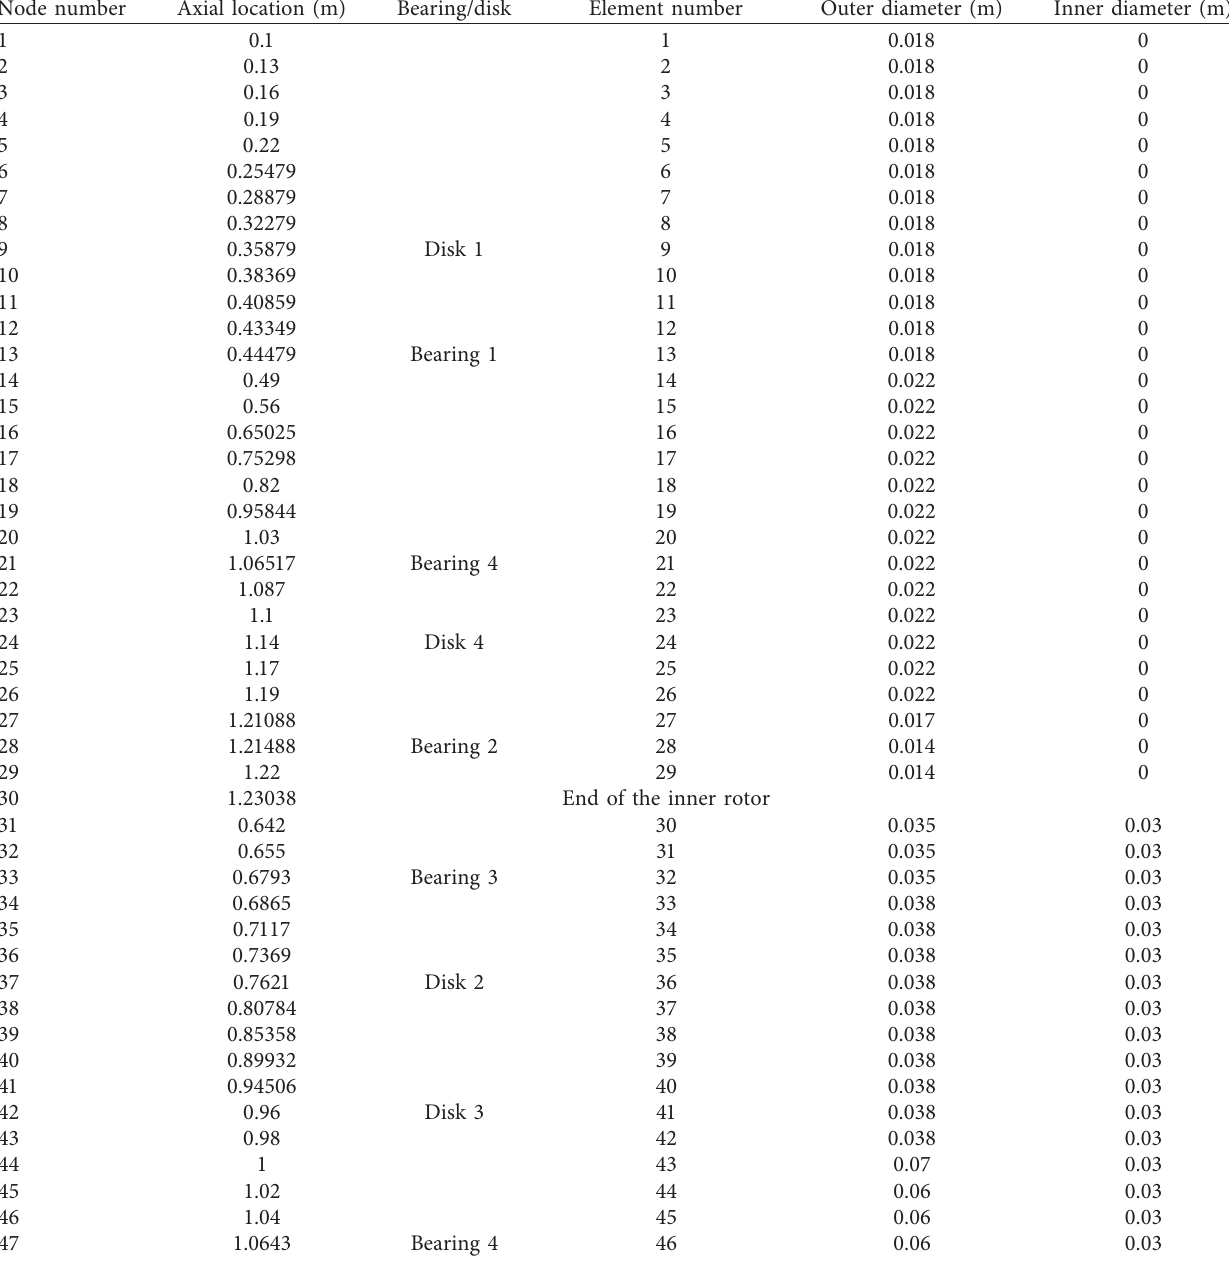
Table 5: Node information of the finite element